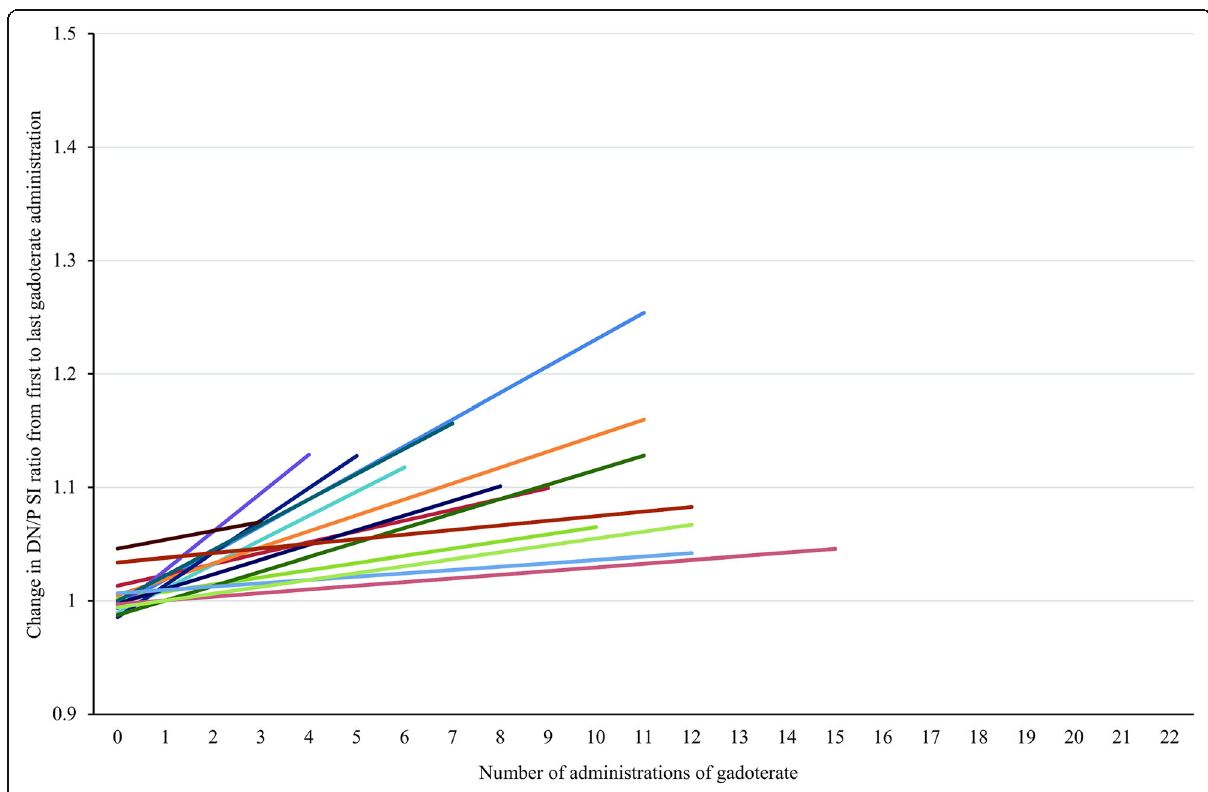
Fig. 3 First and last DN/P SI ratios for patients with visible T1-signal changes after two or more administrations of gadoterate